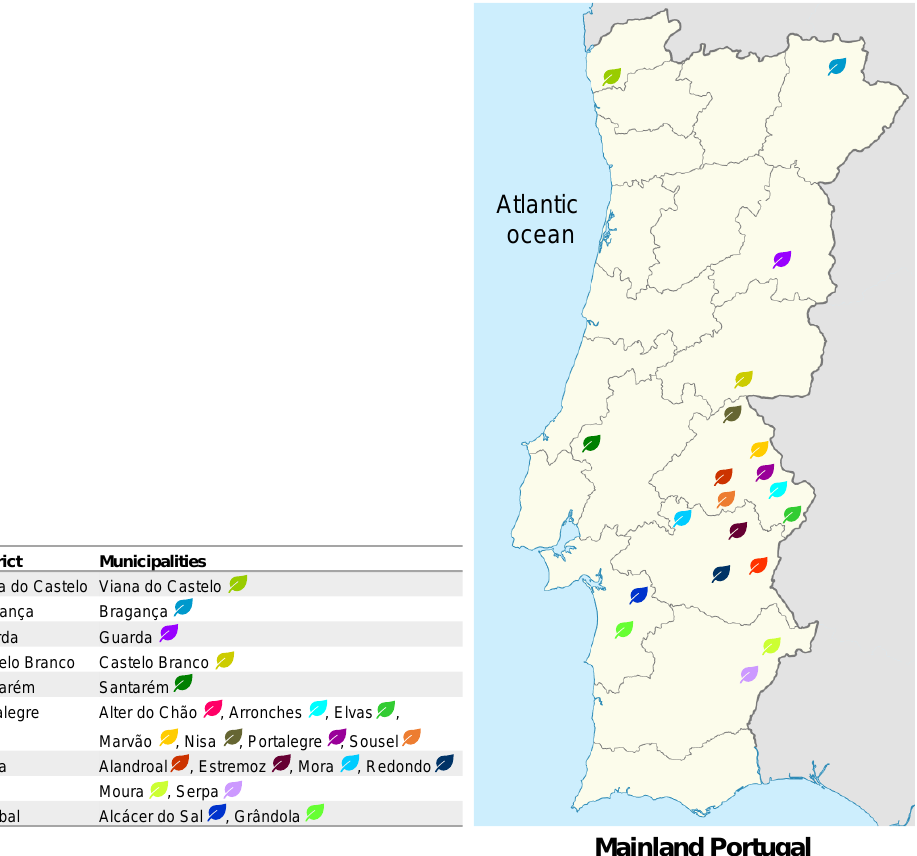
Figure 1. Mainland Portugal geographical origin of the studied oregano samples (n=38).